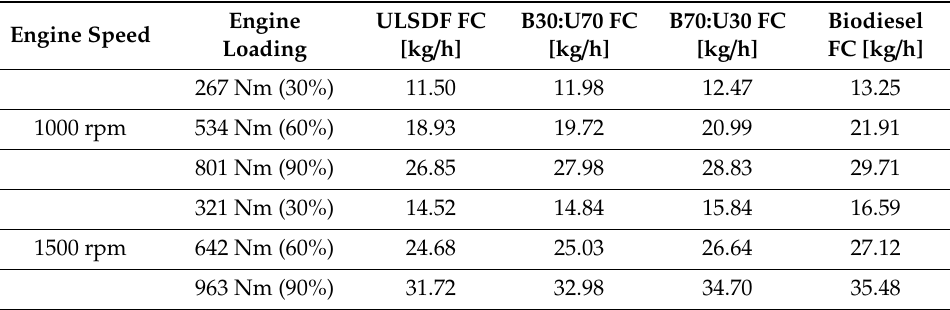
Table 3. Fuel consumption